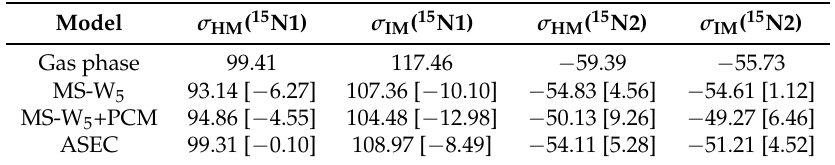
Table 2. B3LYP/6-311++G(2d,2p) results for 15 N shielding constants (in ppm) of HM and IM dimers. Chemical shifts relative to the gas phase are represented in brackets.